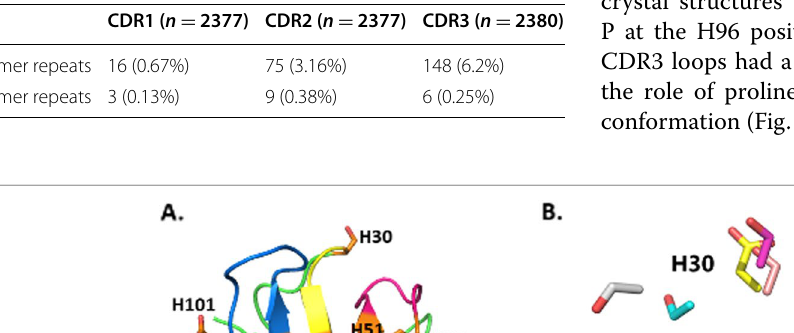
Table 1 Frequency of oligopeptide repeats in the CDR sequences of Nbs